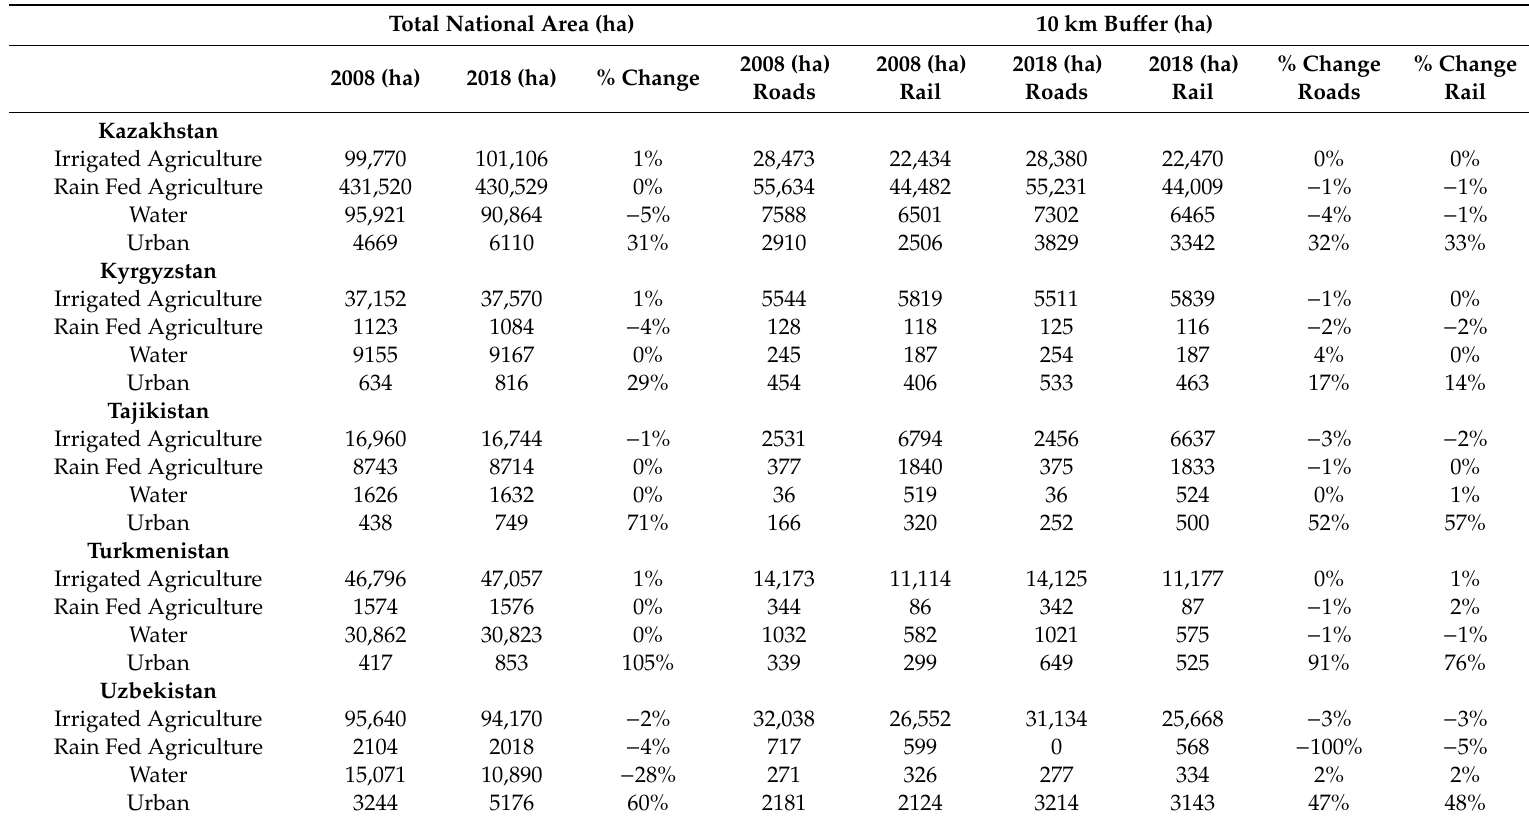
Table 6. Change in irrigated and rainfed agriculture, water resources and urbanization, 2008–2018. Total National Area